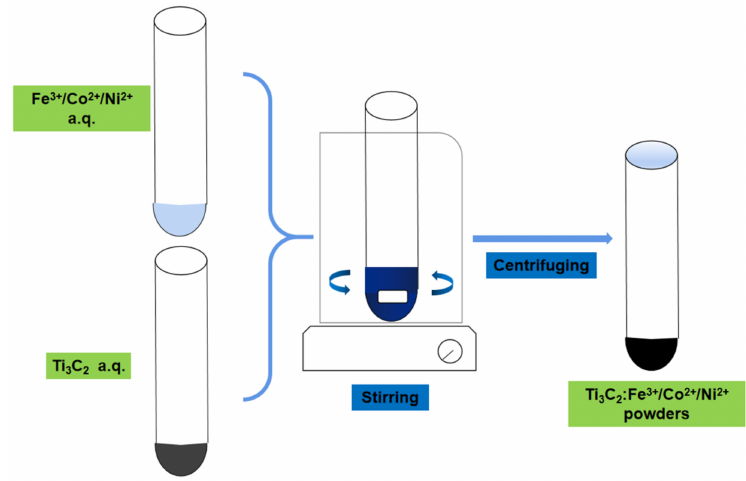
Figure 1. The schematic diagram for the preparation of Ti 3 C 2 :Fe 3+ /Co 2+ /Ni 2+